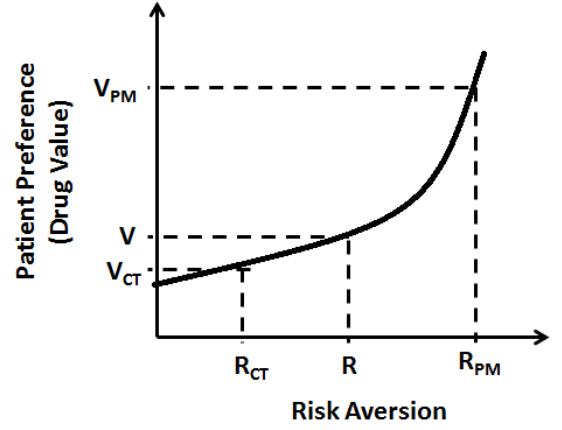
Figure 4. Patient’s perceived differential value to personalized medicine as a consequence of increased risk aversion. V refers to perceived drug value by patient, VPM refers to perceived value of precision medicine, VCT refers to perceived value of current empirical treatment, R refers to patient’s expected risk aversion, RPM refers to risk-aversion by precision medicine, and RCT refers to risk aversion by current empirical treatment.